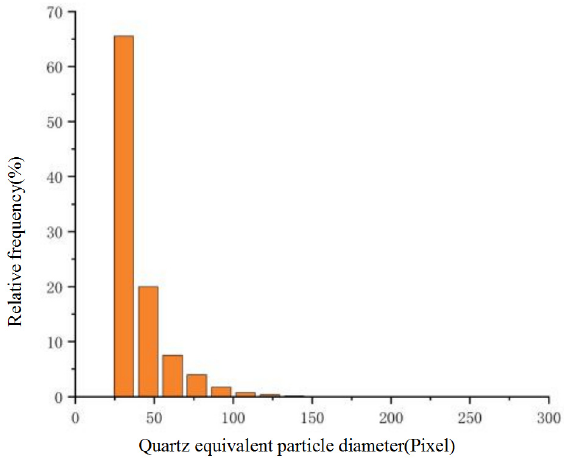
Figure 9. Histogram of equivalent diameter distribution of quartz particles. Table 3. Particle equivalent diameter distribution parameter